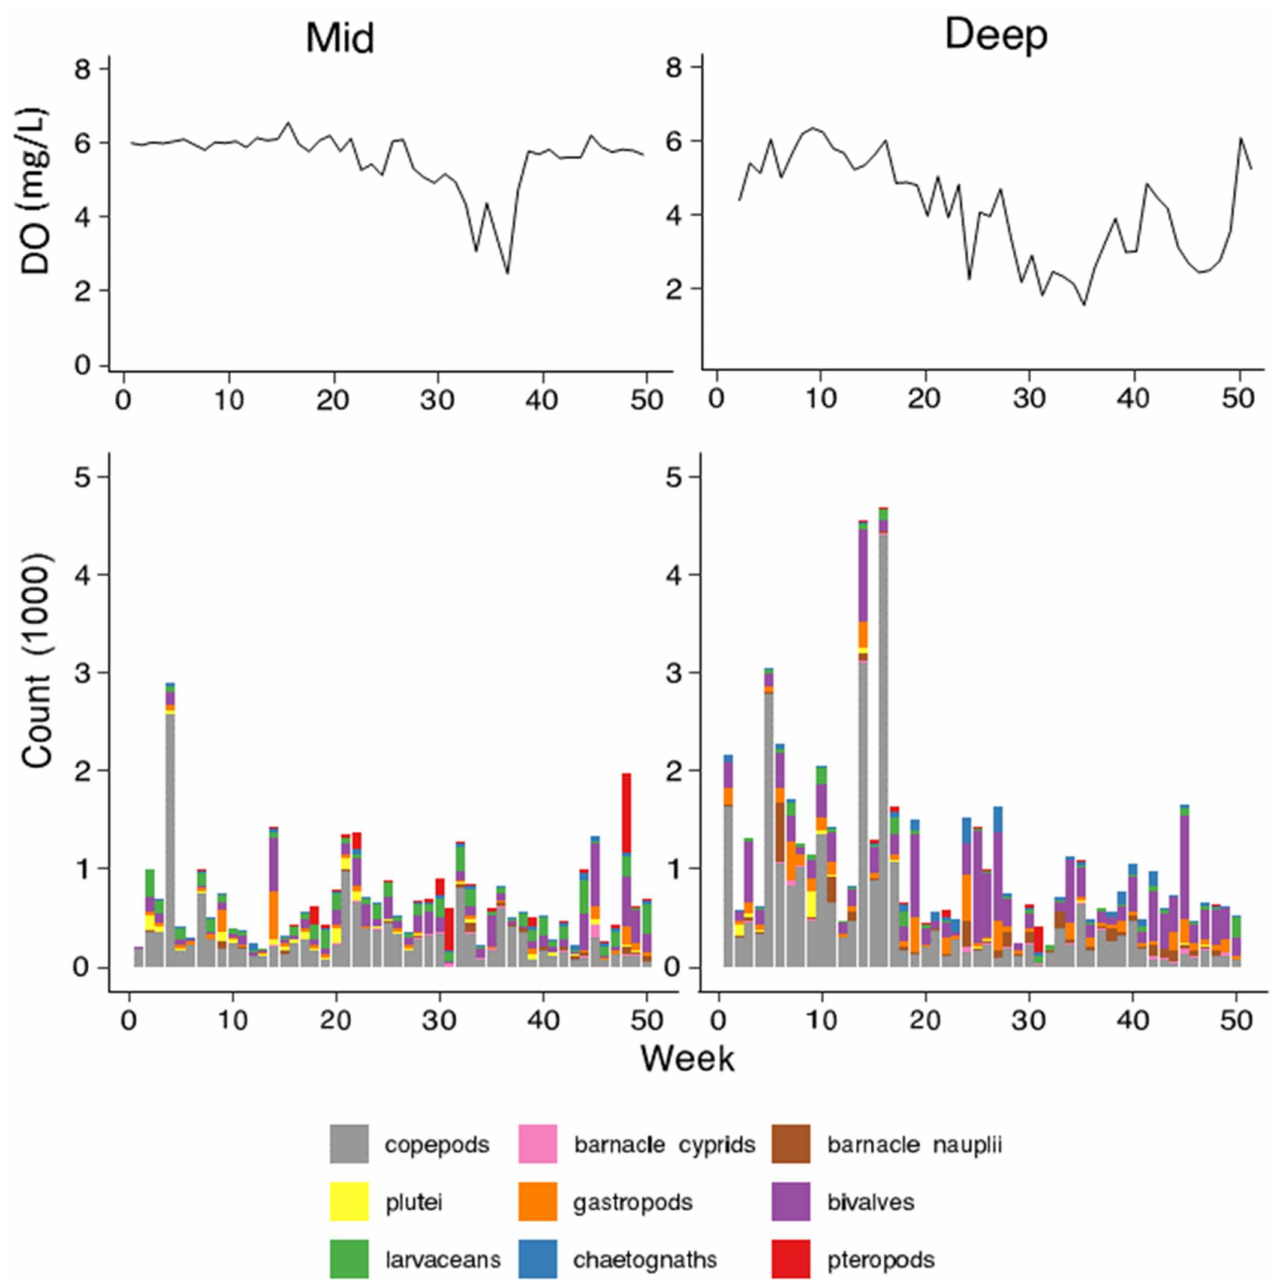
Figure 4. Dissolved oxygen and abundances of the nine focal plankton groups at STRI Point over the 50 weeks of this study, plotted by depth. Count values reported as 1000’s per 379 L